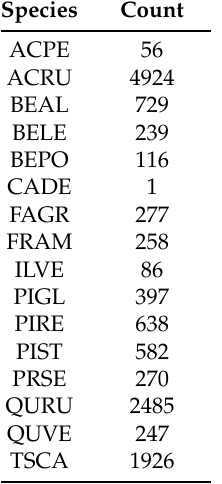
Table 2. HF-EMS species abundance for the 34 tower plots in